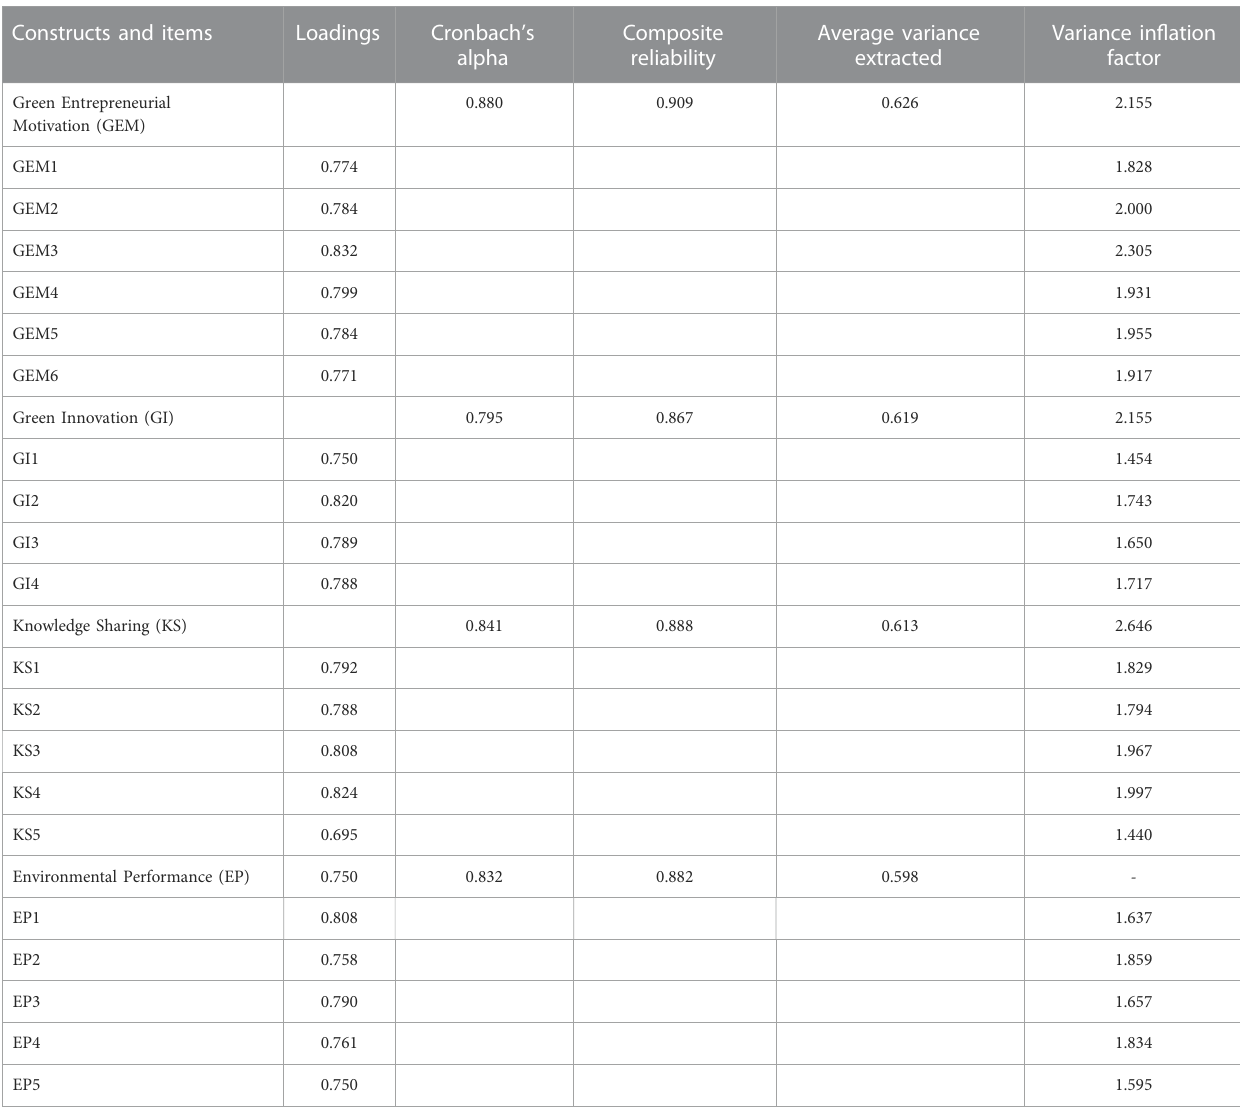
TABLE 1 Reliability, convergent validity and multicollinearity.